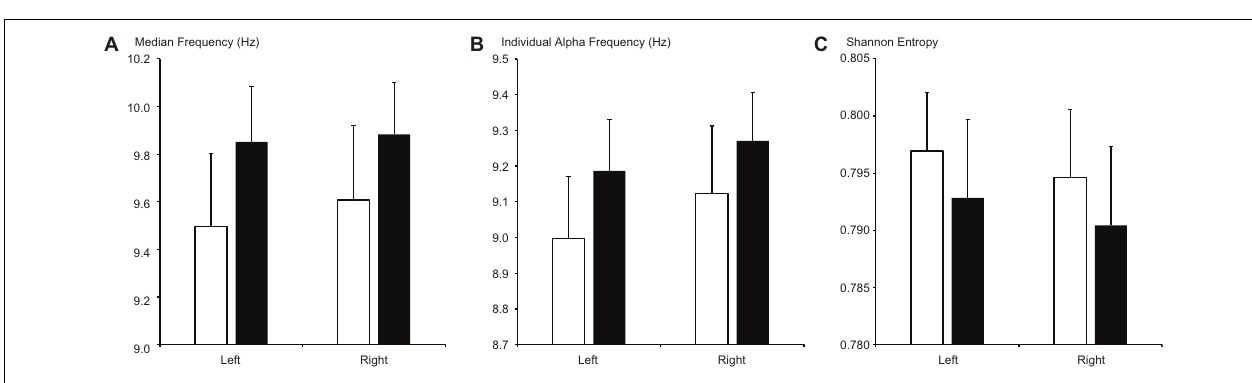
FIGURE 4 | Changes in (A) median frequency, (B) individual alpha frequency, and (C) Shannon entropy between the proliferative phase (open columns) and secretory phase (filled columns). Error bars represent the grand mean of standard errors over bootstrapped iterations. TABLE 1 | Correlation between spectral parameters and participant age/length of the menstrual cycle (Comparison 1 in sensor-level analysis). MF IAF SE Left Right Left Right Left Right